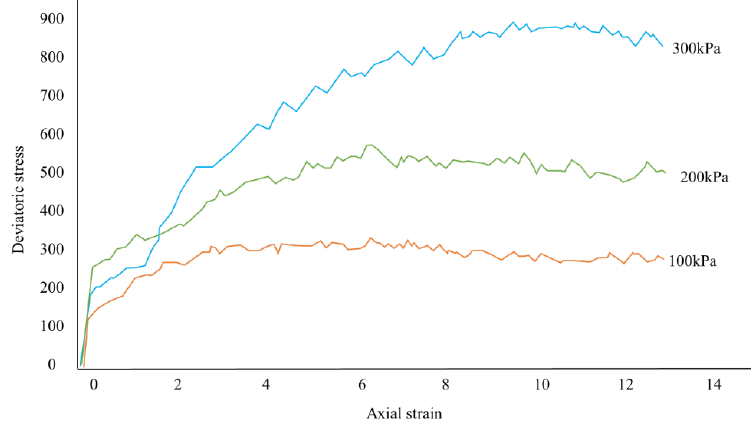
Figure 5. PFC simulation deviatoric stress curves of different sandy soils.